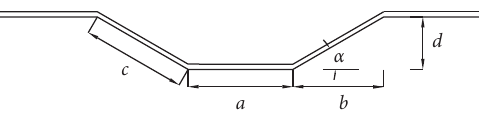
Figure 20: Parameters of corrugated panel geometry. Table 6: Comparison of the ultimate strength calculated by ana- lytical method and FE